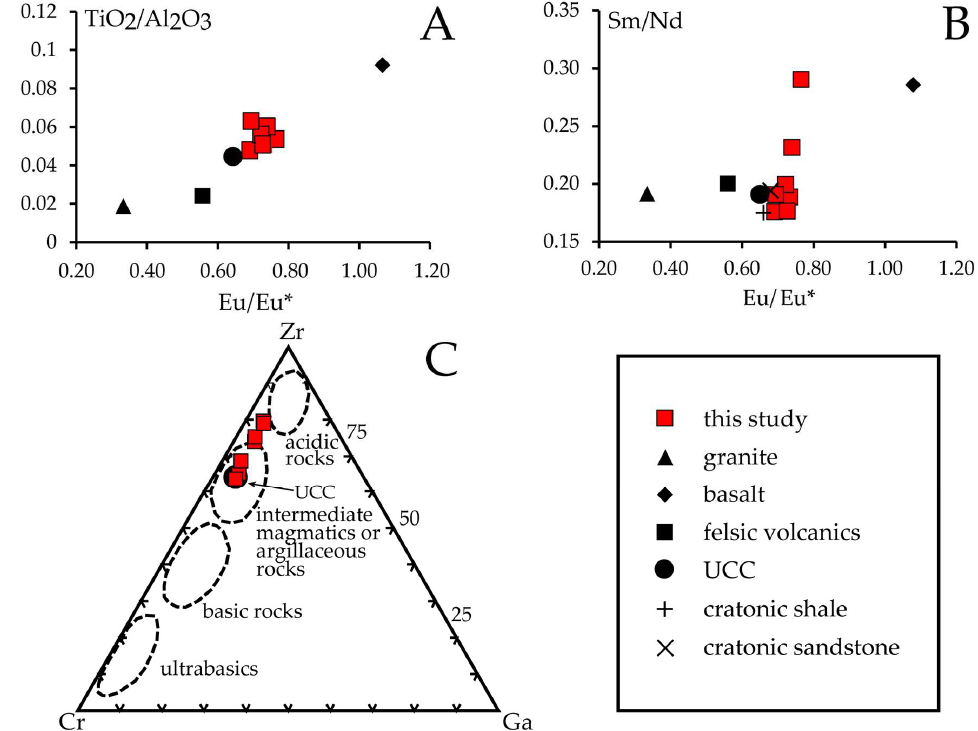
Figure 11. ( A ) TiO 2 /Al 2 O 3 vs. Eu/Eu N * diagram after [30]. ( B ) Sm/Nd vs. Eu/Eu N * diagram after [32]. Note that bauxitic samples from the CCR plot close to values for the Upper Continental Crust (UCC; A , B ) and close to values for cratonic sandstone and shale ( B ). ( C ) Ternary Zr-Cr-Ga plot after [66]. The samples show acidic to intermediate magmatic/ argillaceous parental affinities.